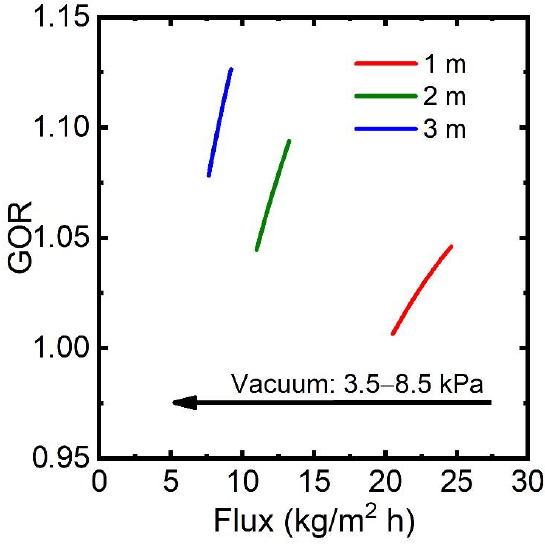
Figure 7. GOR – flux performance for permeate pressure in VMD with varying permeate pressure of 3.5 – 8.5 kPa and module length of 1 – 3 m. Note that GOR and flux are calculated from the